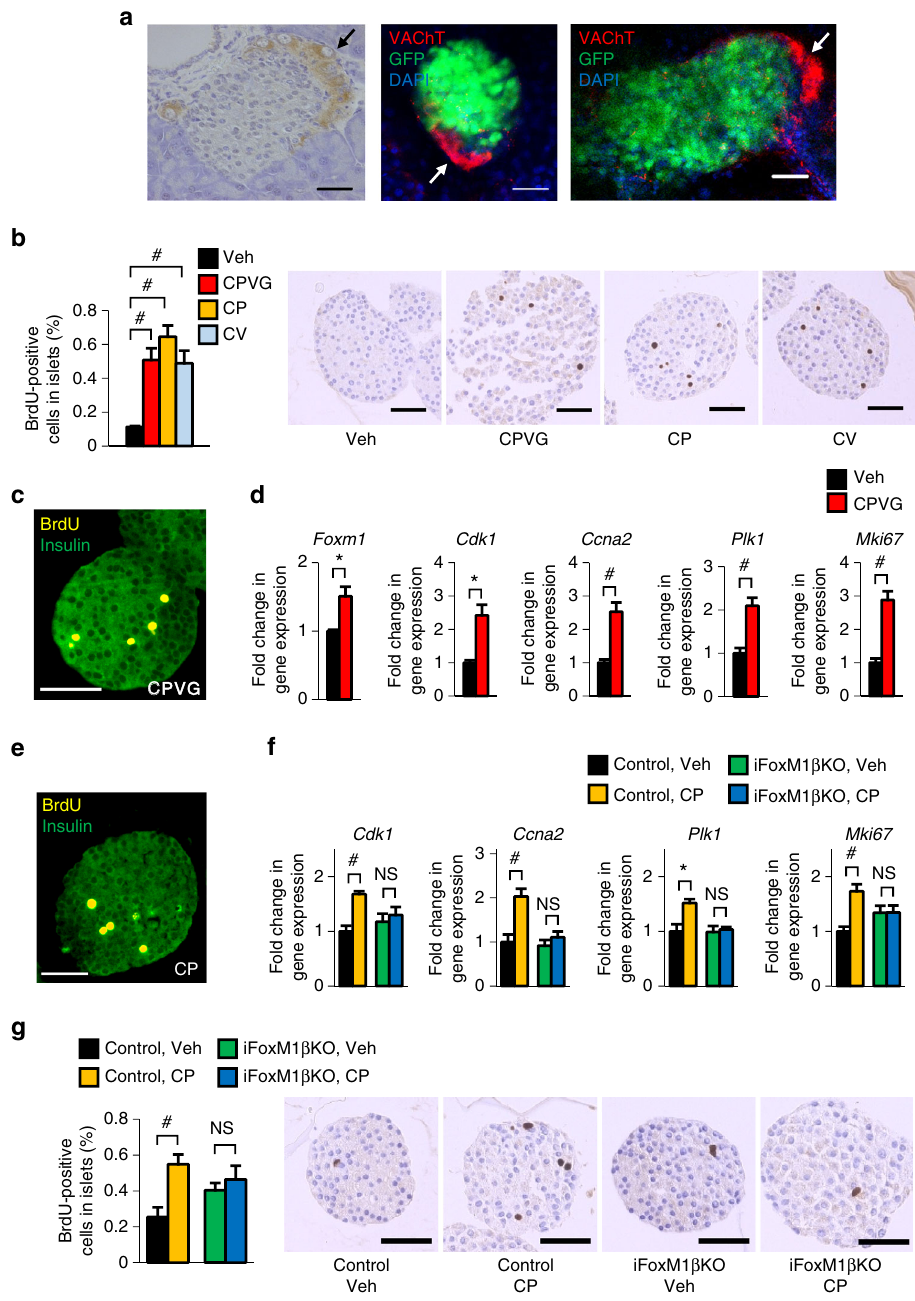
Fig. 4 Treatments combining carbachol with either PACAP or VIP induce β -cell proliferation through a FoxM1-dependent mechanism. a Representative images of parasympathetic ganglia (arrows) are shown. Left: VAChT immunostaining image. Middle, right: Fluorescent immunostaining images. b BrdU- positive cell ratios of CPVG-, CP-, and CV-treated islets, isolated from C57BL/6 N mice, after 48 h incubation; representative images are shown in the right four panels. c Fluorescent immunostaining of CPVG-treated islets, isolated from C57BL/6 N mice. d Expression levels of Foxm1 and its target genes as well as that of the Mki67 gene in CPVG-treated islets, isolated from C57BL/6N mice. e Fluorescent immunostaining of CP-treated islets, isolated from C57BL/ 6 N mice. f Expression levels of FoxM1 target genes and that of the Mki67 gene in CP-treated islets, isolated from iFoxM1 β KO or control mice. g BrdU- positive cell ratios of CP-treated islets, isolated from iFoxM1 β KO or control mice; representative images are shown in the right four panels. BrdU-positive cell ratios and gene expression levels of Veh-treated islets served as controls b , d , f , g . Scale bar, 50 µ m. Data are presented as means ± s.e.m. NS, not signi fi cant, * P < 0.05, # P < 0.01, assessed by unpaired t -test b , d , f , g . n = 5 b , d , n = 4 – 6 f , n = 10 – 12